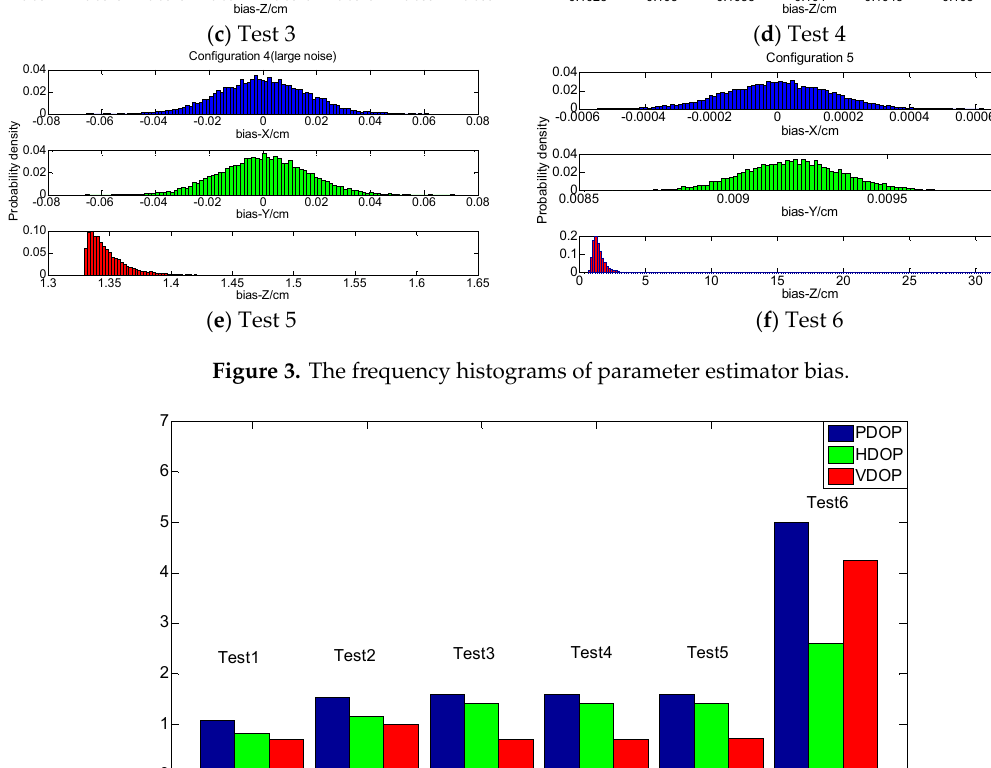
Figure 4. The average position dilution of precision (PDOP), horizontal dilution of precision (HDOP) and vertical dilution of precision (VDOP) for each set of tests.